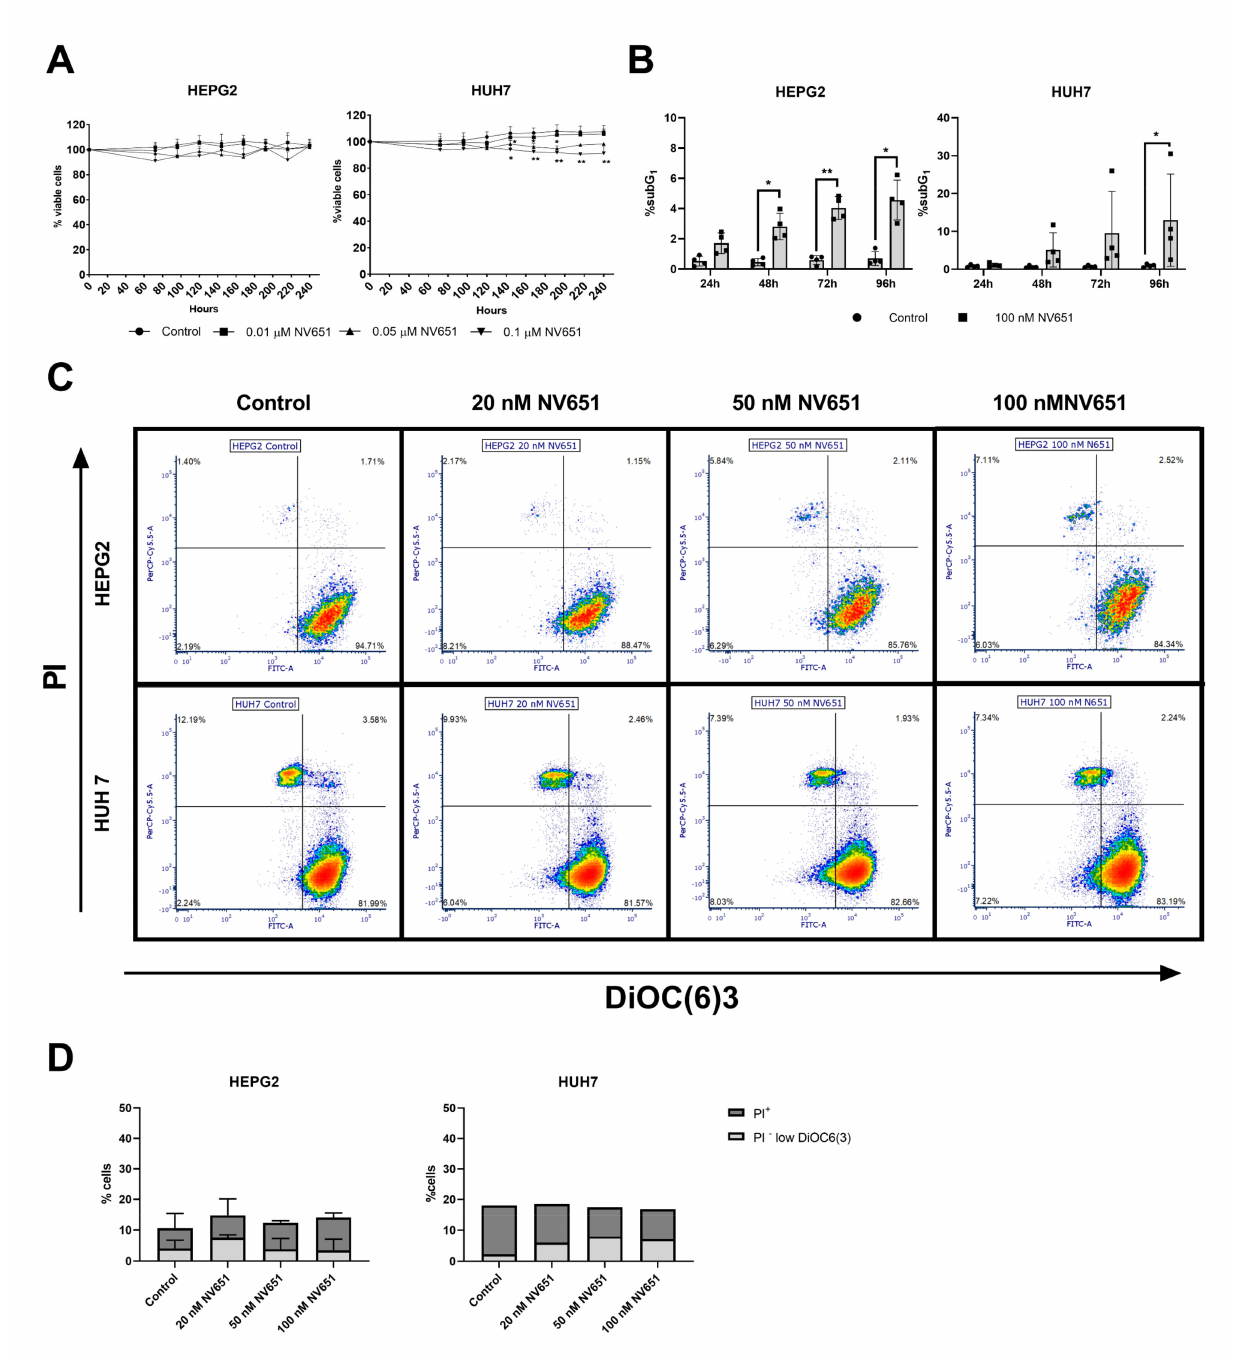
Figure 5. NV651 effect on cell death. ( A ) Nonviable cells are calculated by the ratio between DAPI + cells and AO + cells; % was normalized to day 0, and media with a new NV651 dose was added every 72 h during the experiment. ( B ) The subG 1 fraction from Figure 6B after DMSO or 100-nM NV651 treatment for 24, 48, 72 or 96 h of treatment. ( C , D ) NV651 effect on the mitochondrial membrane potential (pre-apoptotic marker) and PI + cells (late apoptotic + necrotic marker) after 72 h of exposure to the compound. ( C ) Representative density plot of HEPG2 and HUH7. ( D ) Quantification of PI + cells and PI − low DiOC(6)3, equivalent to the low mitochondrial membrane potential, ( A , B ) n = 3 to 4 biological replicates and ( D ) n = 1 to 2 biological replicates. ( A ) Statistically analyzed by 2-way ANOVA, followed by Dunnett’s multiple comparison test. ( B ) Statistically analyzed by 2-way ANOVA, followed by Sidak’s multiple comparison test. Data are presented as the mean ± SD. * p < 0.05 and ** p <